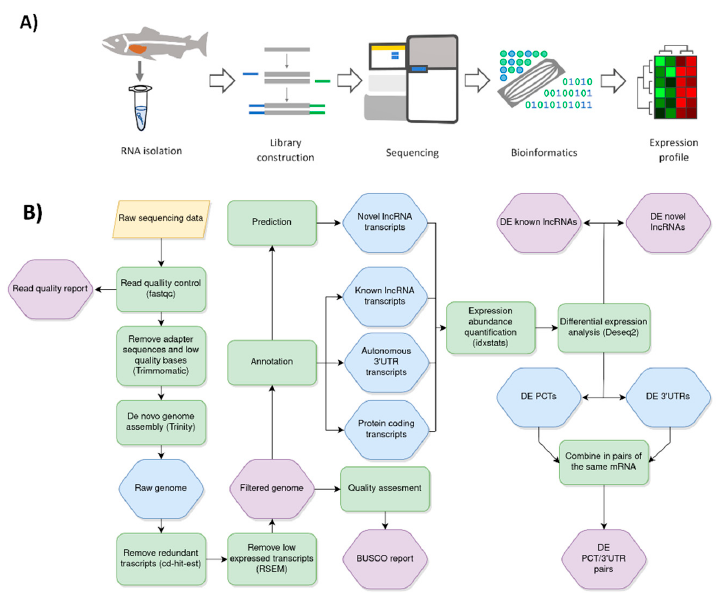
Figure 1. Schematic representation of pipeline used to profile changes in expression of putative long non-coding RNAs (lncRNAs) in microcystin-LR (MC-LR)-induced liver damage in whitefish. ( A ) Overview of the experimental procedure. ( B ) Bioinformatic analysis workflow. Yellow shapes indicate pipeline input, green shapes indicate action step taken in analysis, blue shapes indicate output of an action, purple shapes indicate final output. DE, differentially expressed; PCTs, protein coding transcripts. Int. J. Mol. Sci. 2021 , 22 , x FOR PEER REVIEW